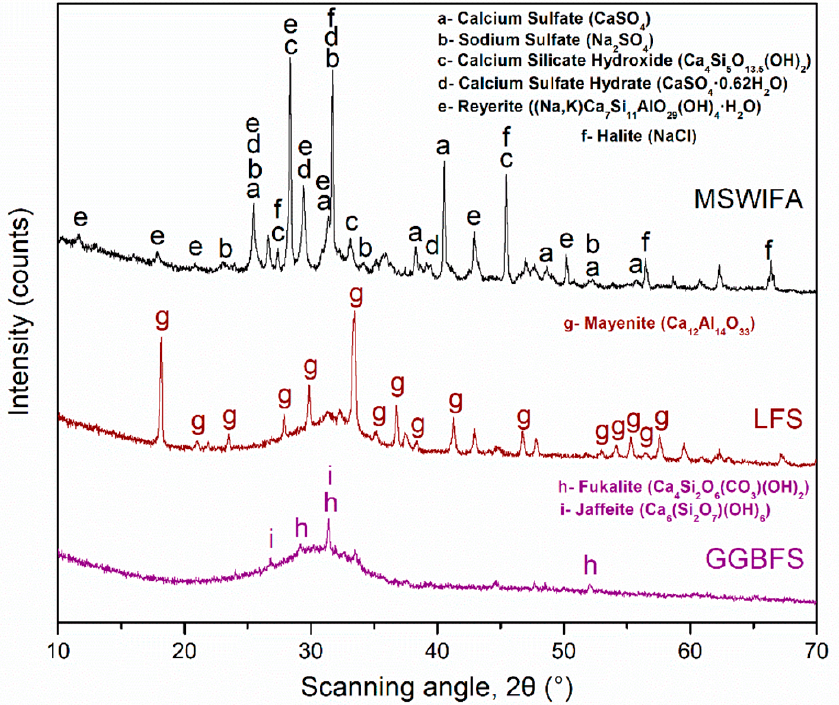
Figure 1. X-ray diffraction ( XRD) patterns for MSWIFA, LFS, and GGBFS [16,22] (PDF#: